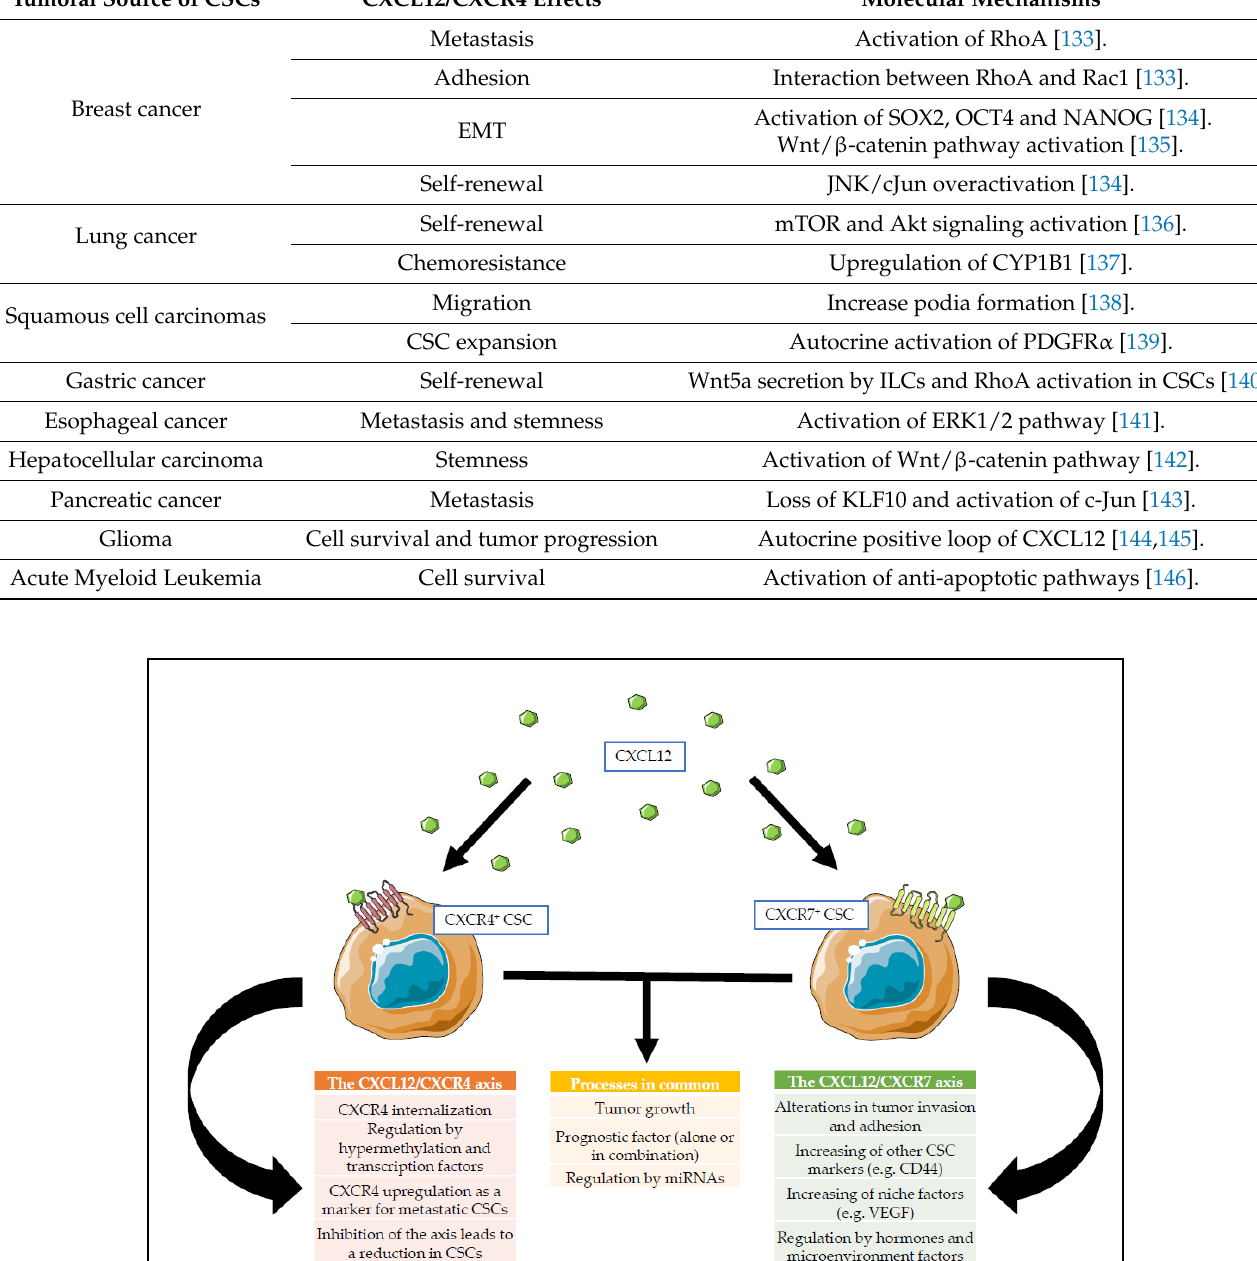
Table 1. Effects of the CXCL12/CXCR4 axis in CSCs and their molecular mechanisms.